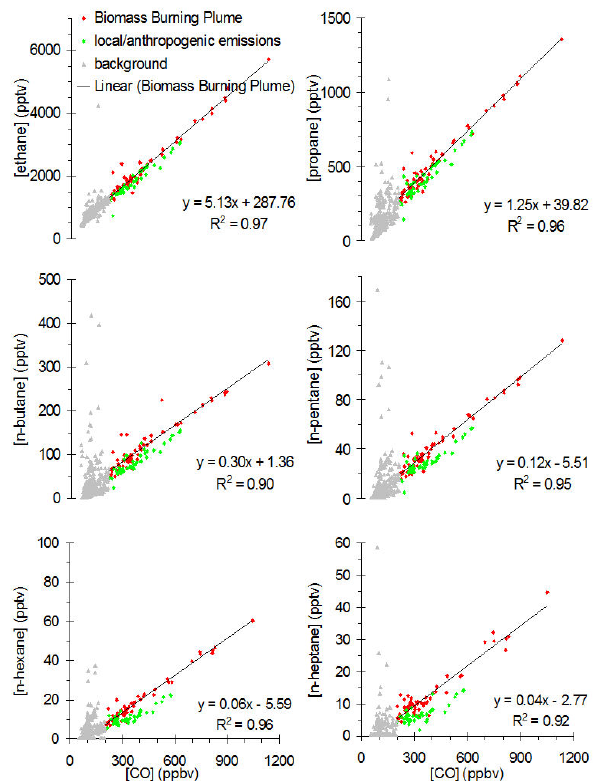
Fig. 2a. Selected plots of alkanes vs. CO. Grey triangle assigned as background air, red diamonds assigned as biomass plumes and green diamonds assigned as anthropogenic